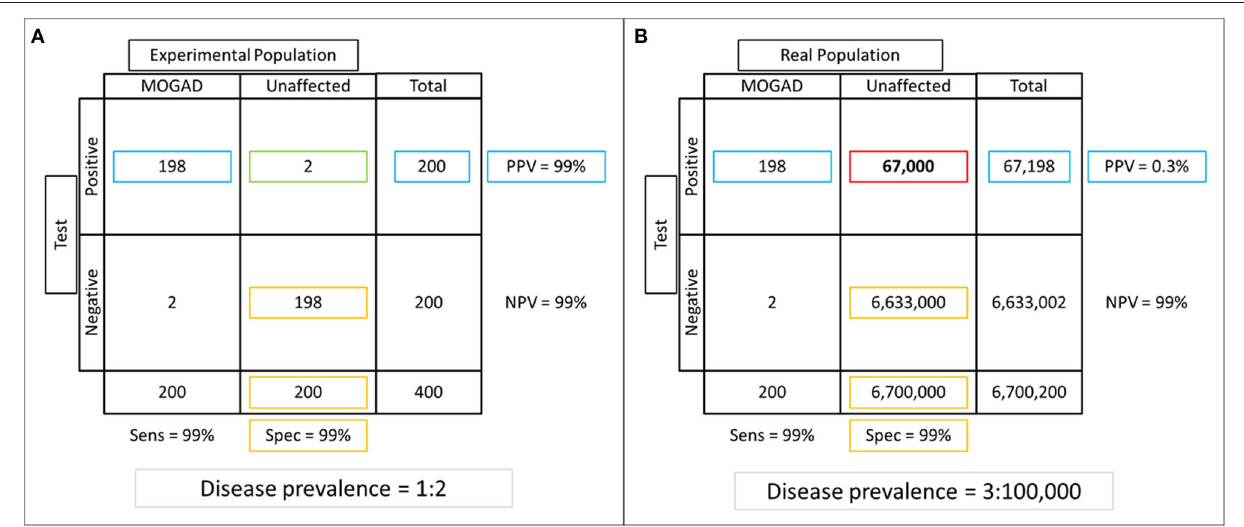
FIGURE 4 | Example of specificity and positive predictive value (PPV) assessment in experimental vs real-life settings. (A) An experimental population composed of equal number of patients with the disease of interest and unaffected controls is tested (frequency of the disease of interest in the tested population = 50%). Of 200 positive results obtained after autoantibody testing, 2 (1%) are false positives (green box), while the majority of those who tested negative were true negatives ( n = 198), for a specificity of 99% (true negatives divided by total unaffected patients; yellow boxes). The PPV (number of true positives divided by total positive results) is also very high in this setting (99%; blue boxes). (B) If the same test is performed in a hypothetical metropolis of 6,700,200 inhabitants where the disease prevalence is 0.003%, notice that the number of false positive results increases dramatically to 67,000 (red box). While this variation in frequency of false positive results does not affect specificity (99%, yellow boxes), which is an intrinsic characteristic of the test and thus not affected by the characteristics of the population tested, it has a huge impact on the PPV that decreases to 0.03% (blue